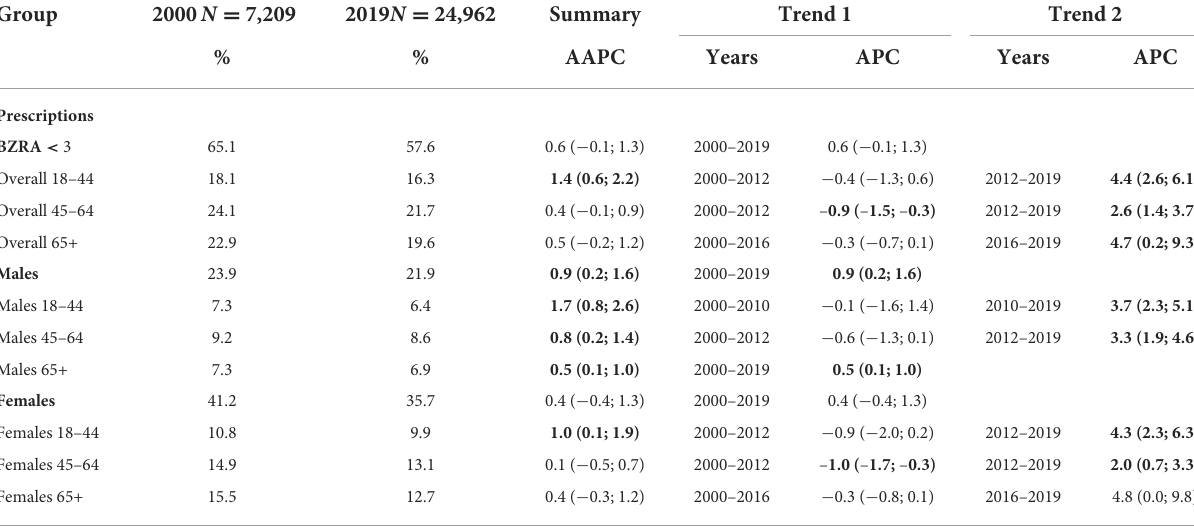
TABLE 3 Trends in age- and sex-standardized BZRA prescription rates among patients who received < 3 BZRA prescriptions in 1 year between 2000 and 2019. Group